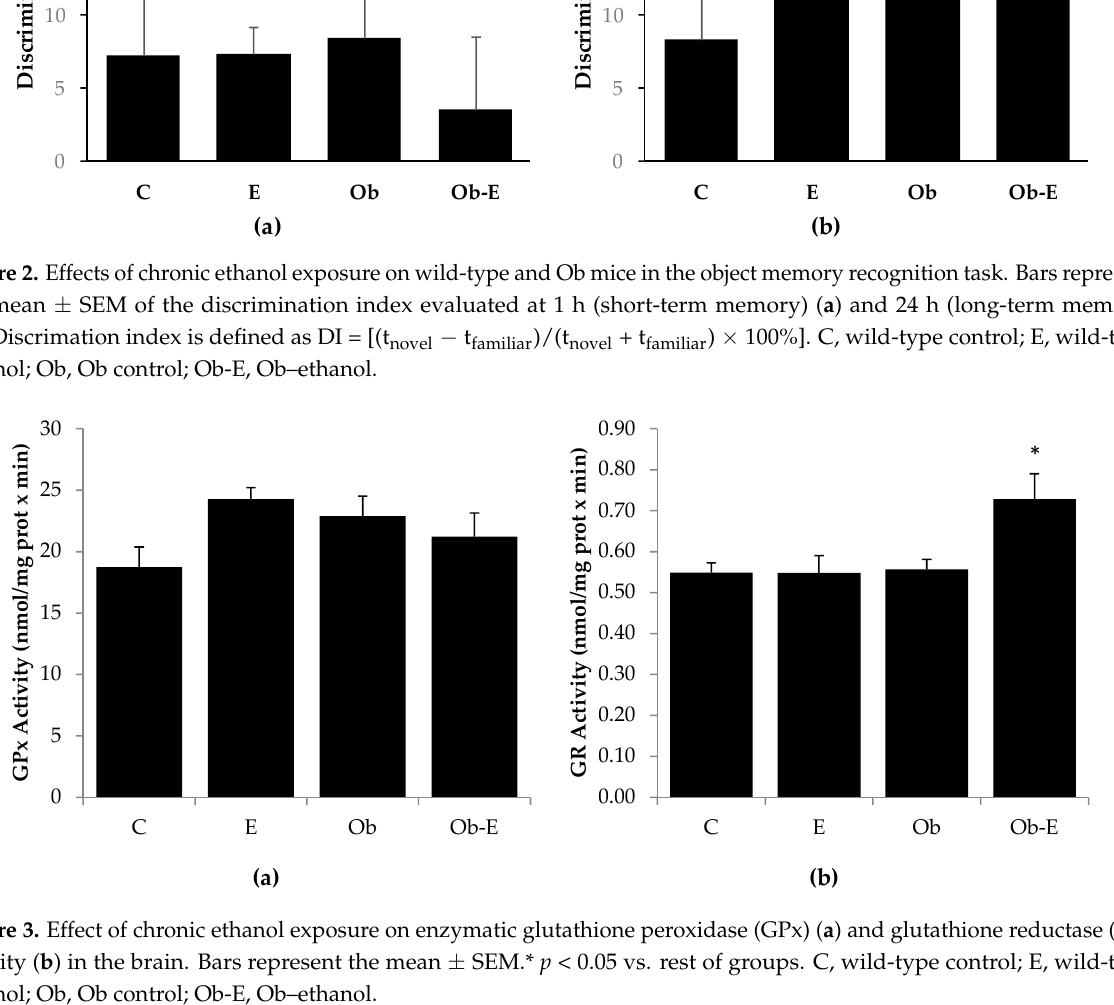
Figure 2. Effects of chronic ethanol exposure on wild-type and Ob mice in the object memory recognition task. Bars rep- resent the mean ± SEM of the discrimination index evaluated at 1 h (short-term memory) ( a ) and 24 h (long-term memory) ( b ). Discrimation index is defined as DI = [(t novel − t familiar )/(t novel + t familiar ) × 100%]. C, wild-type control; E, wild-type ethanol; Ob, Ob control; Ob-E, Ob–ethanol.